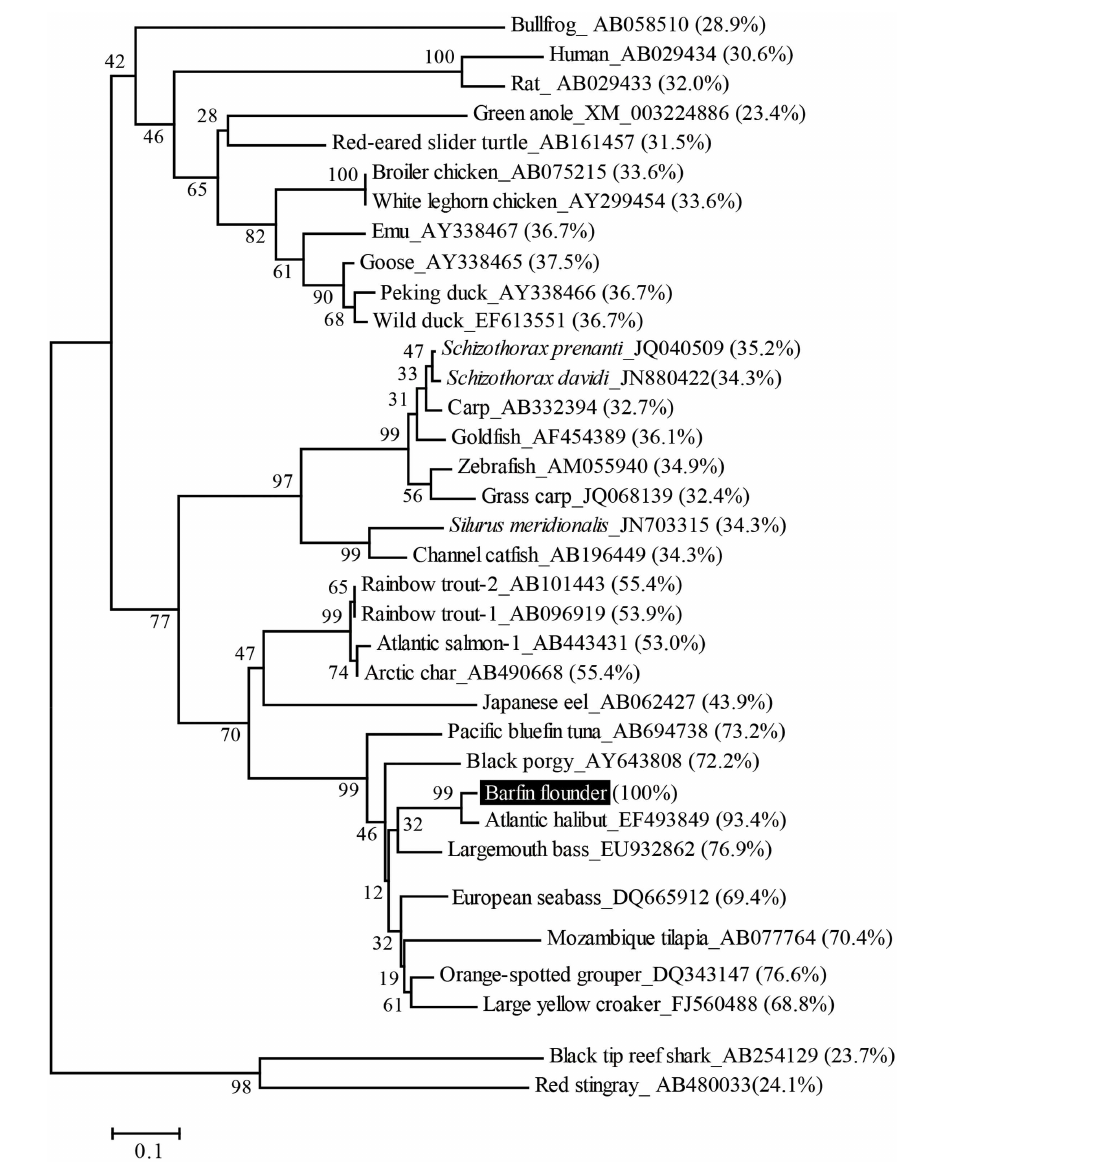
FIGURE 2 | Phylogenetic analysis of the barfin flounder prepro-ghrelin .The phylogenetic tree was generated by means of the NJ method of the MEGA4 software package (http://www.megasoftware.net/).The GenBank accession numbers follow the species names, the percentages in parentheses indicate amino acid identities to the barfin flounder prepro-ghrelin, and the numbers at the branch points represent bootstrap values (1000 repetitions).